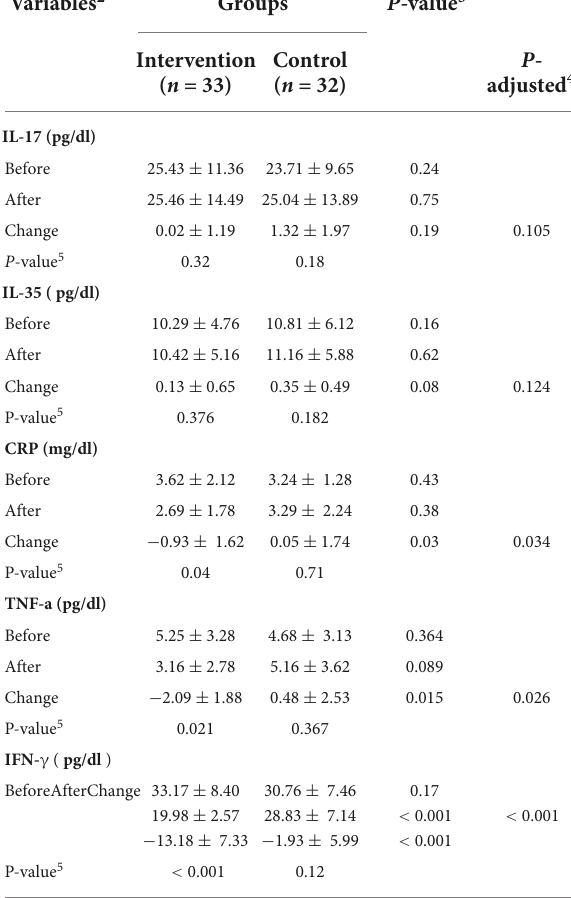
TABLE 2 Comparison of inflammatory biomarkers between groups at the baseline and end of the study 1 .